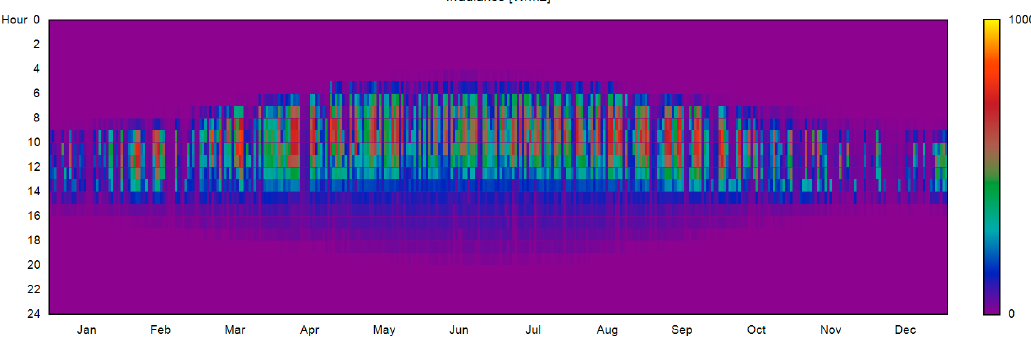
Figure 7. Hourly irradiance profile for vertical integrated photovoltaic (PV) module with Southeast (SE) orientation.